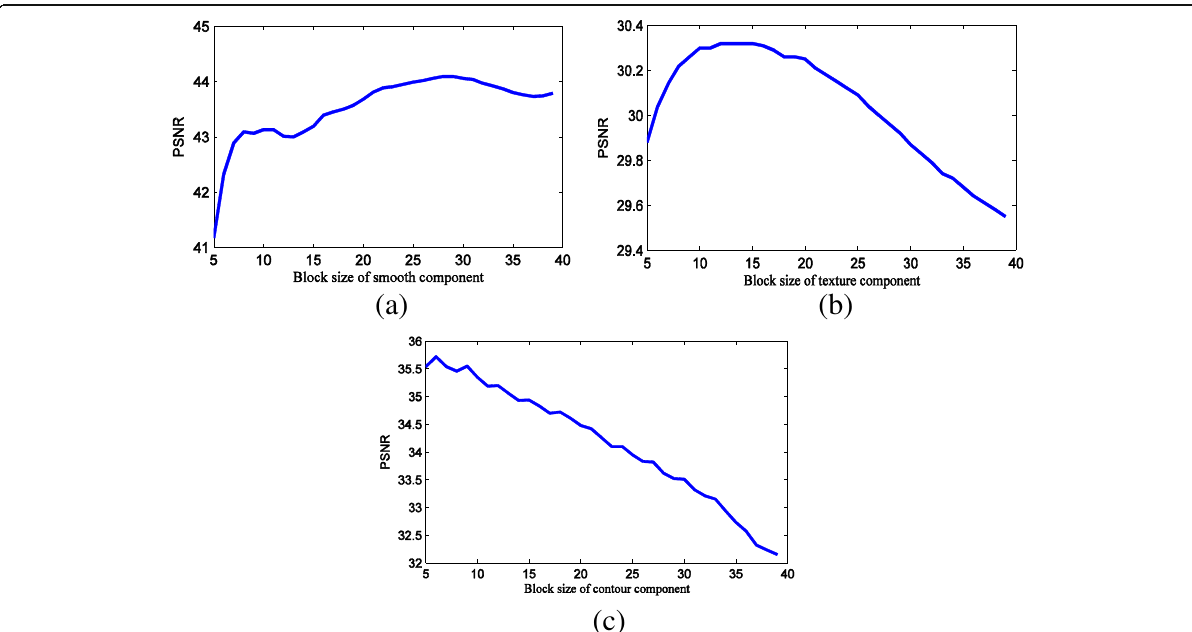
Fig. 3 Changes of denoising result with respect to the use of different block size, for three image blocks with a smooth component, b texture component, and c contour component,